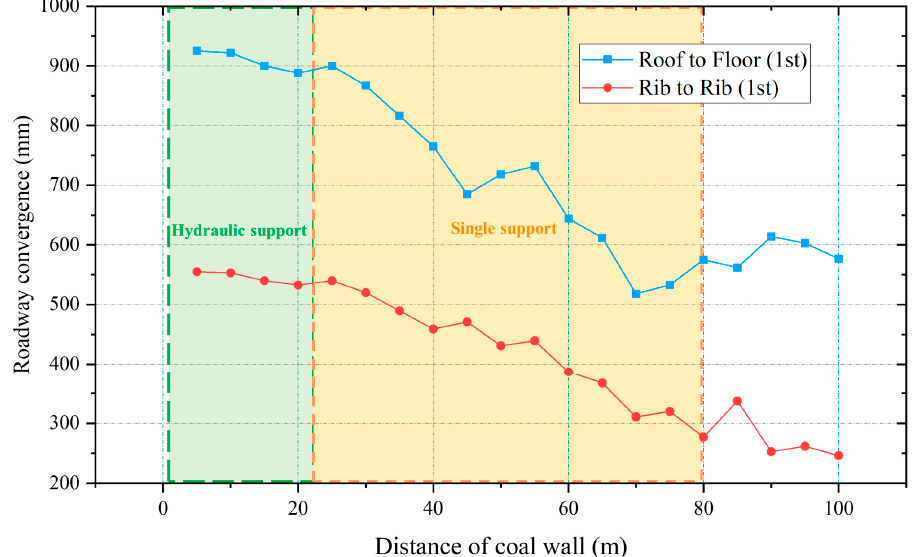
Figure 3. Roadway deformation curve.